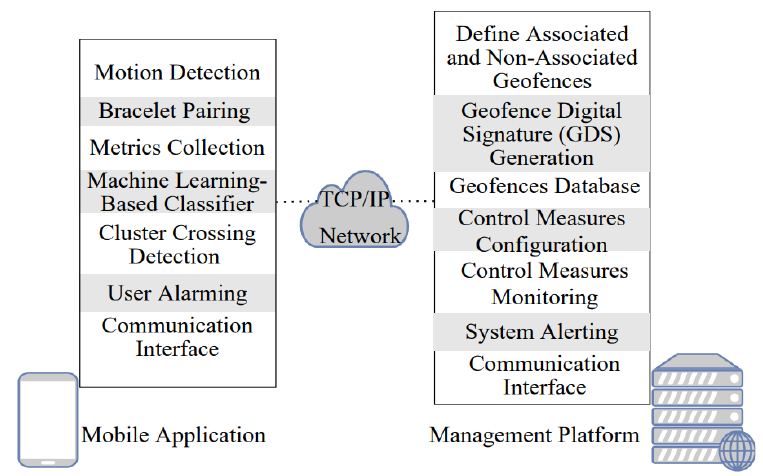
Figure 2. Functional block diagram for the proposed approach.